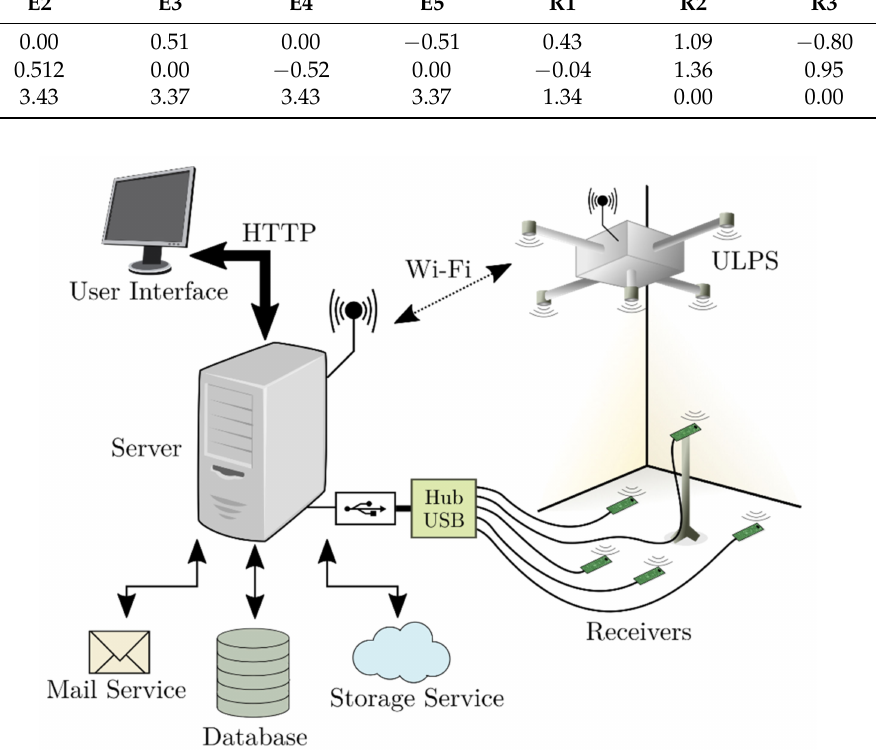
Figure 15. General block diagram of the server designed for the CODEUS online